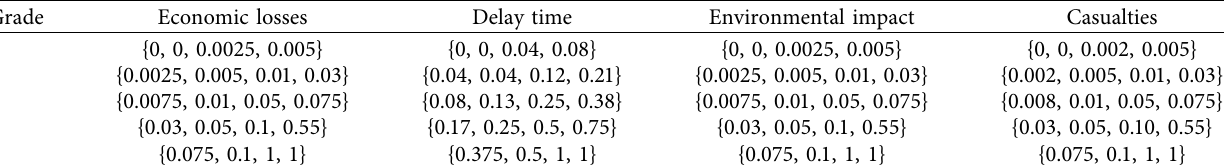
Table 5: Relationship between risk loss grade and membership function after